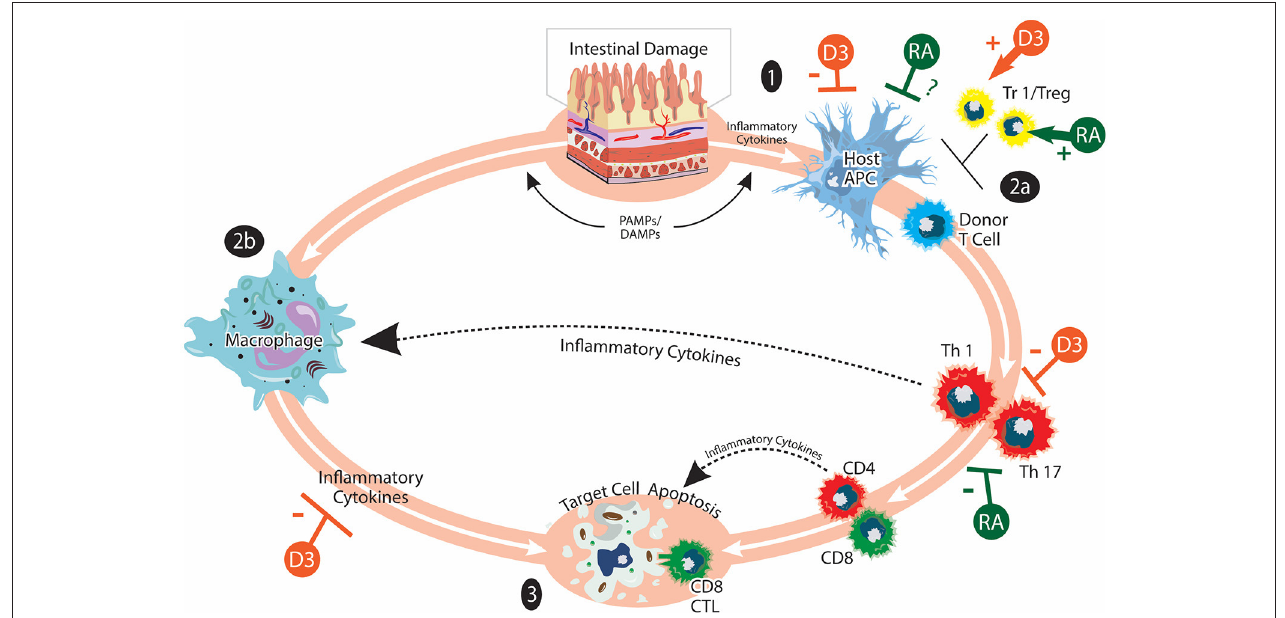
FIGURE 1 | Acute GVHD and vitamins A and D. aGVHD pathogenesis involves: (1) Activation of host APCs due to release of inflammatory cytokines and PAMPs/DAMPs from tissue damaged by HSCT conditioning. Intestinal damage by conditioning serves to amplify inflammatory responses. (2) Activation of donor T cells when they encounter host APC. Donor T cells undergo differentiation, expansion, and acquisition of tissue homing specificity during this stage (2a). Inflammatory cytokines produced by donor T cells and bacterial LPS can further activate innate immune cells such as macrophages (2b). (3) Inflammatory mediators from donor T cells and innate immune cells lead to target cell apoptosis. Cytotoxic CD8T cells can mediate direct cell killing. Tr1/Tregs play immunomodulatory roles in aGVHD pathogenesis. The effects of vitamin A/RA (shown in green) on aGVHD are complex and not completely understood. Vitamin A/RA promotes donor T-cell intestinal homing. Inhibiting donor T-cell RAR signaling suppresses the induction of gut-homing molecules and favors Treg cell differentiation. It has also been reported that RA inhibits donor T cell expansion and cytokine production. The potential effects of vitamin A/RA on host APCs are currently under investigation. The effects of vitamin D (shown in orange) on aGVHD may include suppressing the activation of host APCs, inhibiting the activation and cytokine production of donor T cells as well as promoting the induction of Tr1/Treg. The figure is adapted from Ferrara et al.